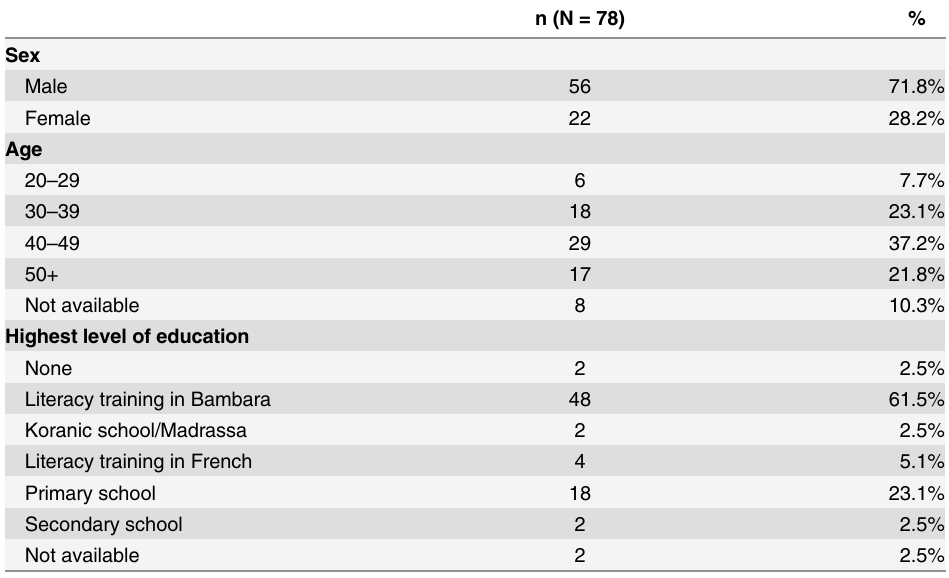
Table 1. Characteristics of relais participating in the RMM study in